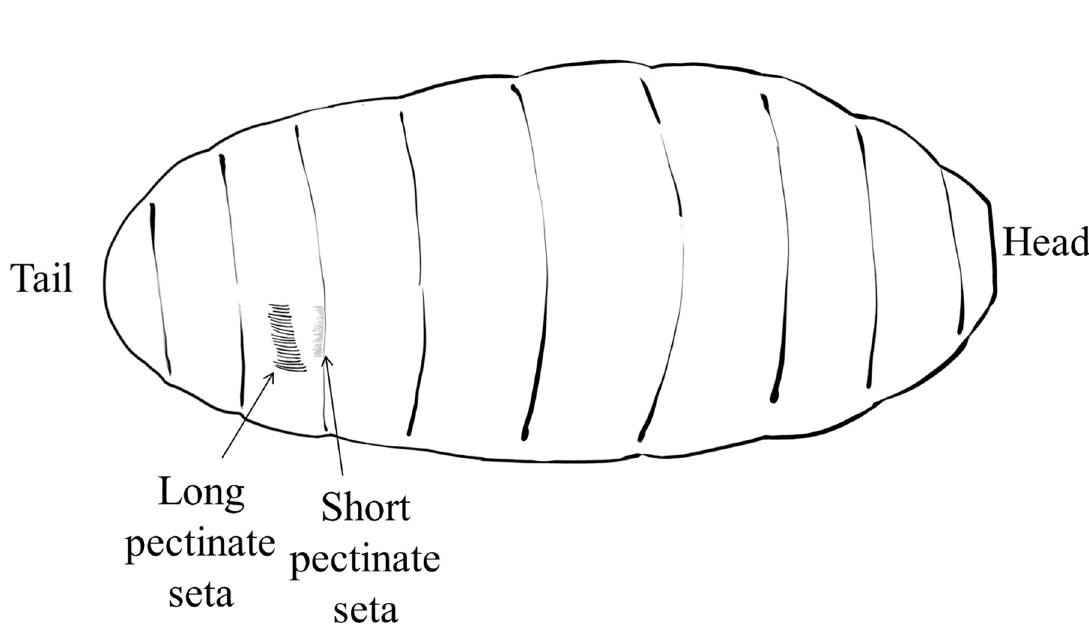
Fig 4. Side view of